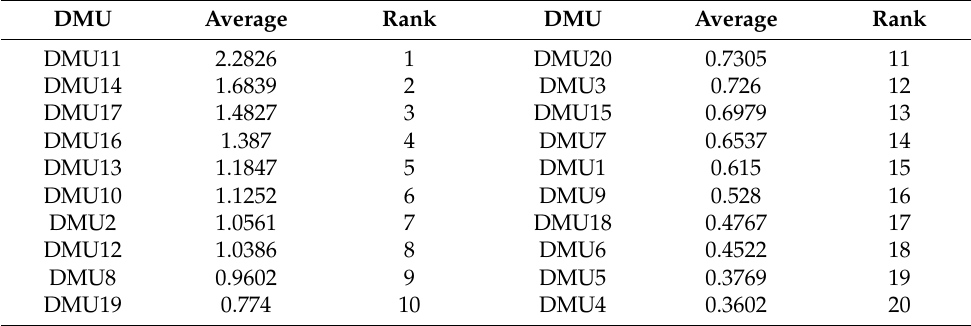
Table 9. Future efficiency and ranking before strategic alliance.